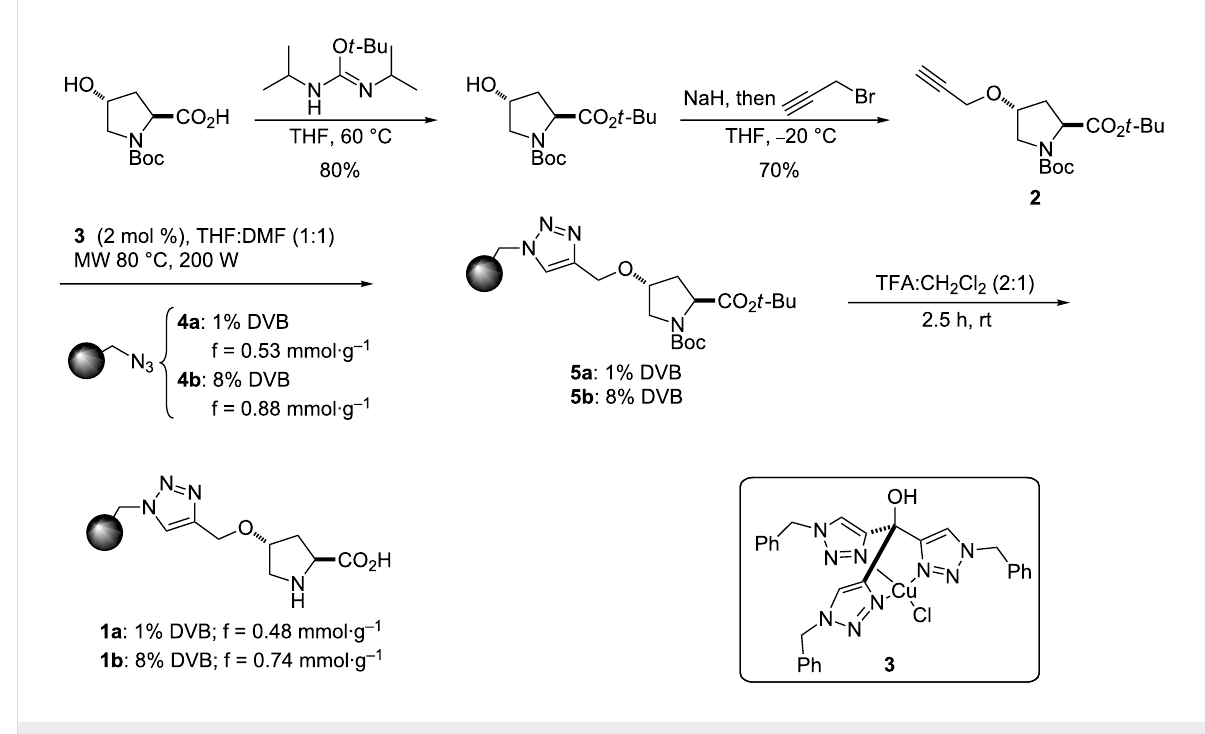
Scheme 2: Preparation of the immobilized catalysts 1a and 1b